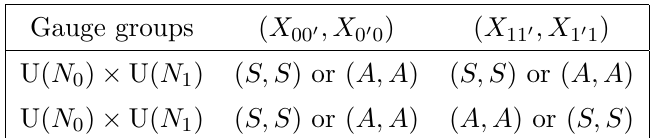
Table 16. The orientifold projection ^(cid:10) of C = Z 2 . \A" stands for \Antisymmetric representation", while \S" for \Symmetric